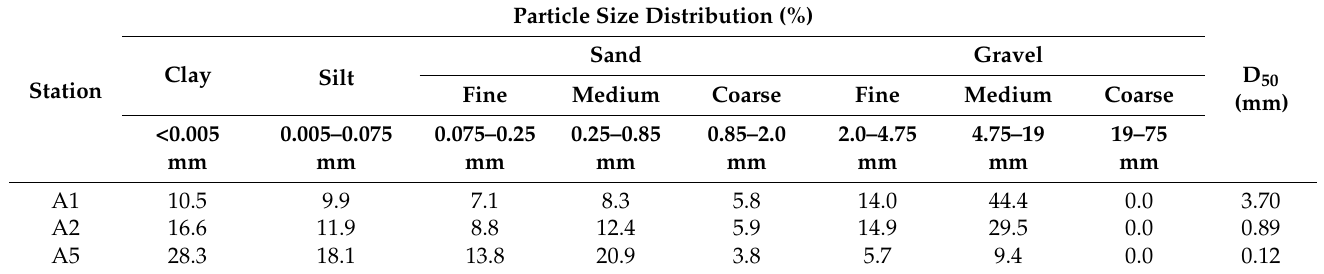
Figure 3. Frequency distribution of flow speed and direction at 3 m above the bottom of A5 (non-reef station) from 25 July to 7 August 2018. Flow speeds and directions were measured every one second for two minutes at an interval of twenty minutes through the period. Table 2. The particle size distribution and D 50 (median diameter) of the bottom sediment at A1, A2, and A5.